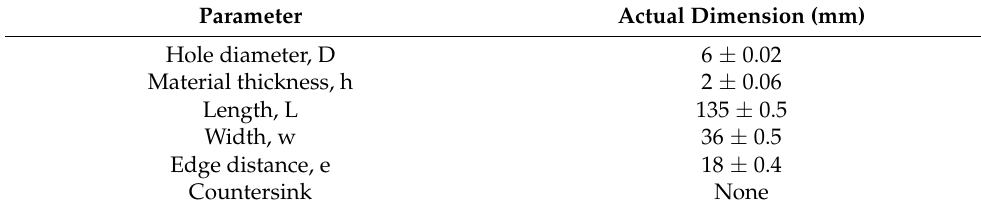
Table 4. Specification of actual dimensions on CFRP workpiece (SI).